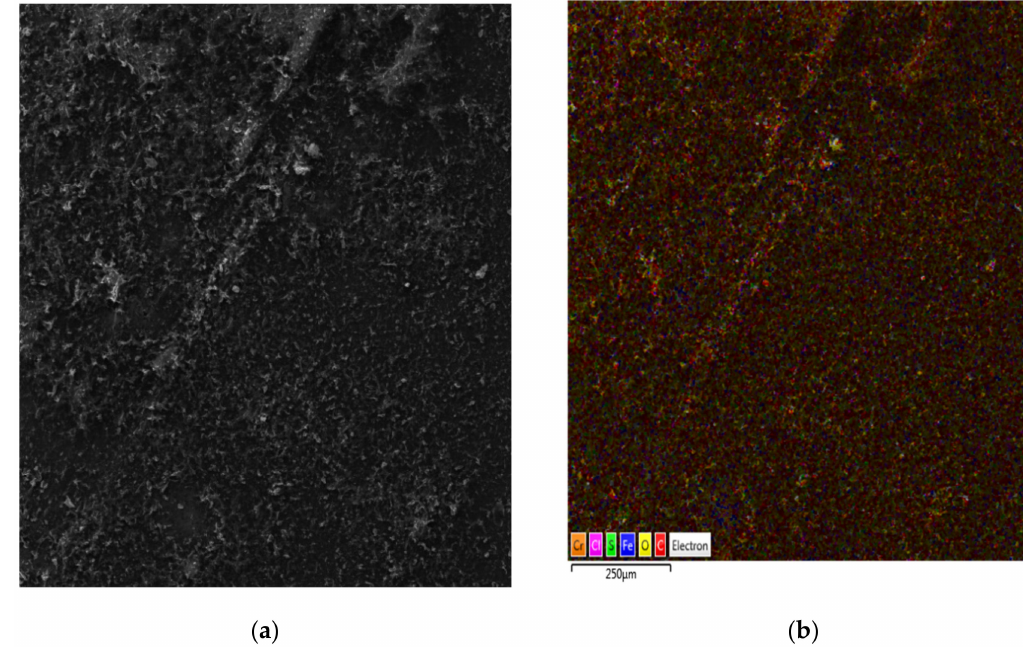
Figure 13. Characterization of electrophoretically deposited GO film on stainless steel (scale 200 µ m). Films with cover microstructure are shown in micrographs, ( a ) SEM image and ( b ) EDX image.